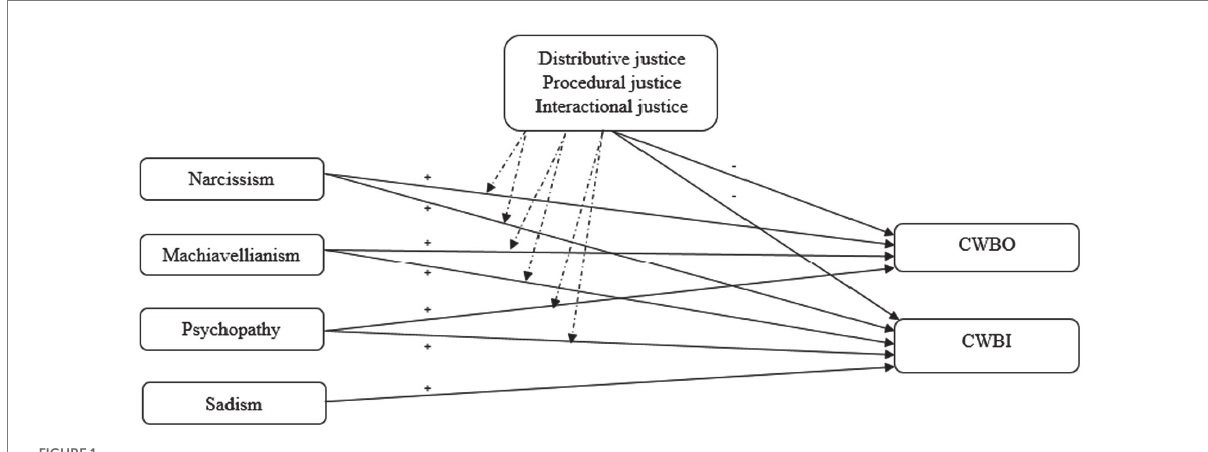
FIGURE 1 Conceptual model. Note. A continuous arrow indicates a direct relation. A discontinuous arrow indicates a moderating relation. CWBO = counterproductive work behaviors targeting the organization; CWBI = counterproductive work behavious targeting